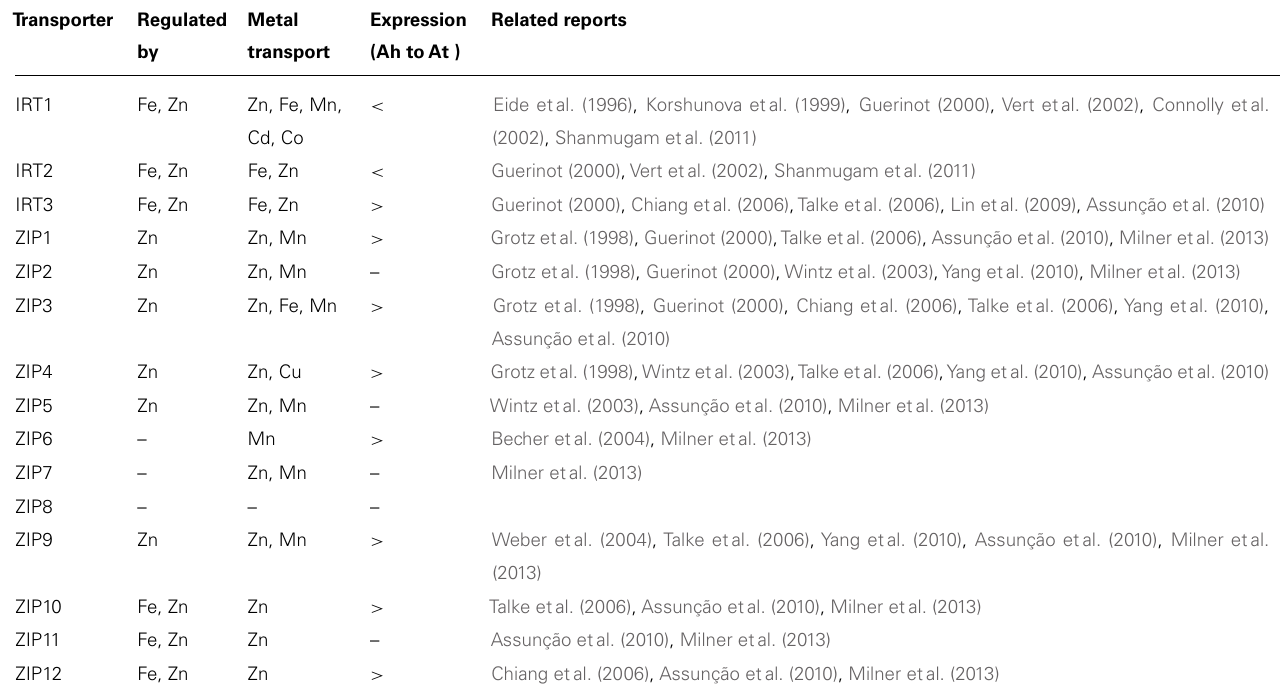
Table 1 | Expression and transport properties of ZRT/IRT-like protein (ZIP) transporters. Transporter Regulated Metal Expression by transport (Ah toAt